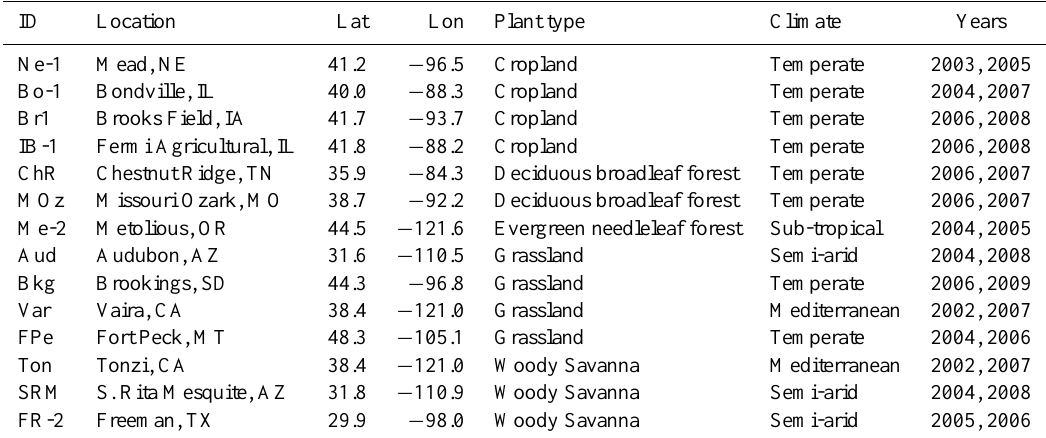
Table 1. Study site information. The ID represents the standard AmeriFlux identification code, and the column Years reports the 2 observation years analyzed for each